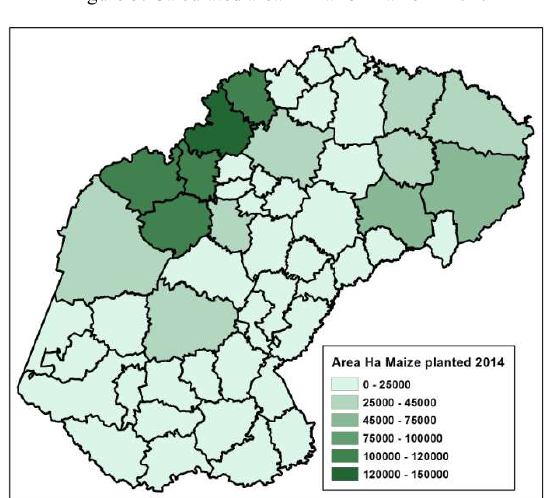
Figure 3. Calculated area in Ha for maize in 2010